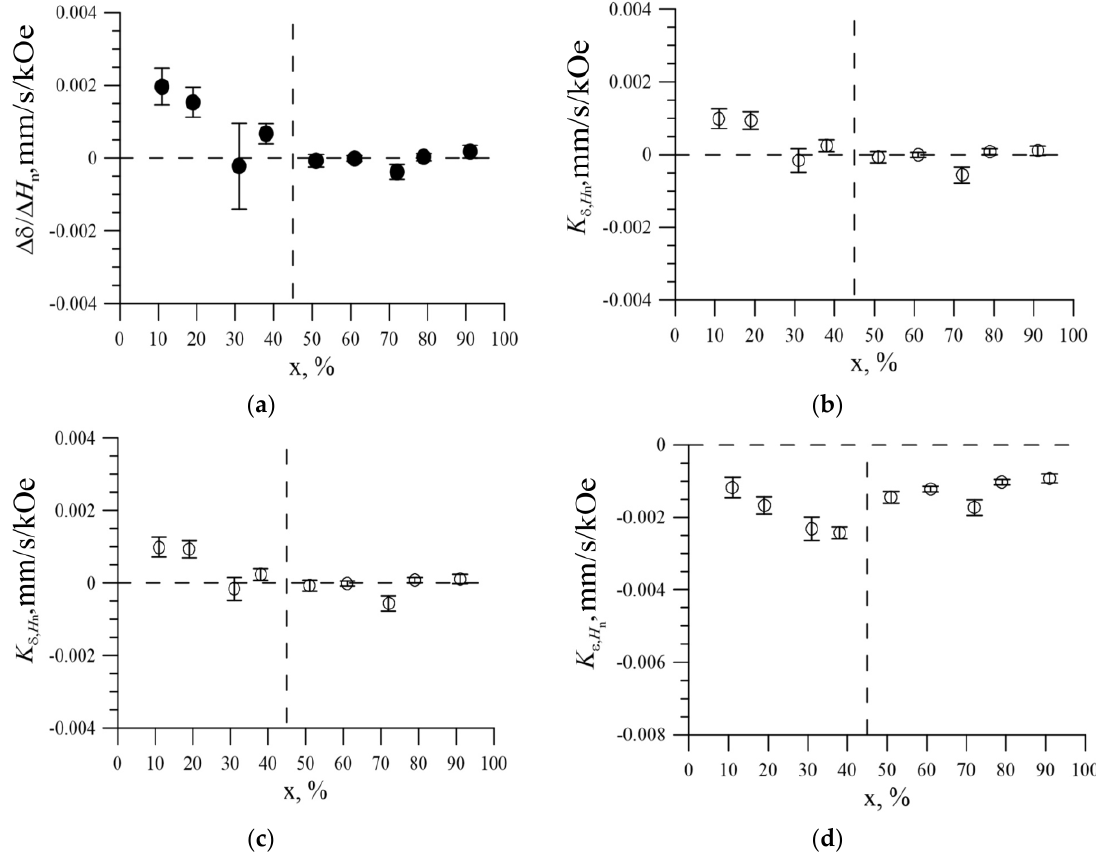
Figure 13. ( a ) The concentration dependence of the ratio of the change in the shift of the Mössbauer line to the change in the hyperfine magnetic field; ( b ) Concentration dependence of the ratio of the quadrupole shift change to the change in the hyperfine magnetic field; ( c ) The concentration dependence of the linear correlation coefficient of the shift of the Mössbauer line δ and the hyperfine magnetic field H n when the position of the iron atom changes in the structure of nanotubes; ( d ) Concentration dependence of the linear correlation coefficient of the quadrupole displacement of the line ε and the hyperfine magnetic field H n when the position of the iron atom changes in the structure of nanotubes.